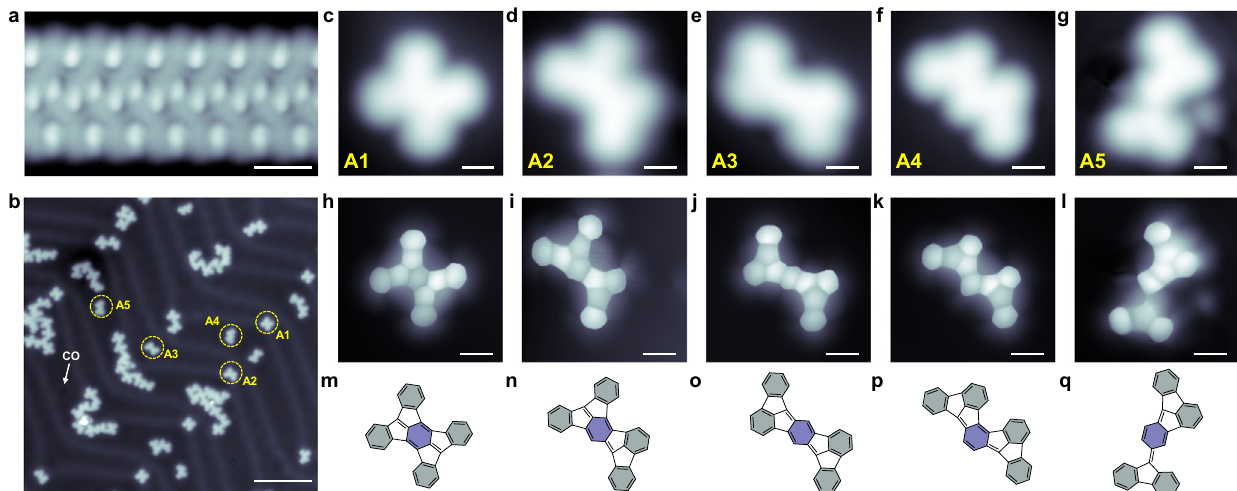
Fig.2|ProductsformedafterthermalannealingofDMTPBonAu(111)at590K. a STMtopographiesoflinearself-assemblyofDMTPBonAu(111). b Large-scaleSTM topography (CO tip, I =50pA, V s =100mV) after thermal annealing at 590K. c – g Constant current STM topographies (CO tip, I =50 pA, V s =100mV) of the products A1 , A2 , A3 , A4 ,and A5 ,respectively,asdenotedin( b )withdashedyellow